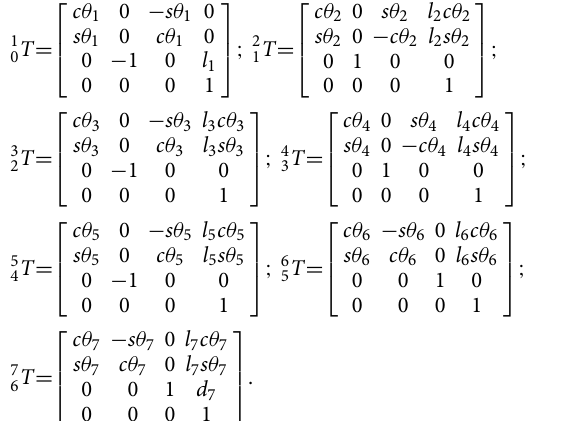
The FK equation of the end-effector relative to the base is produced by multiplying all homogeneous trans- formation matrices, as shown in Eq. (24).